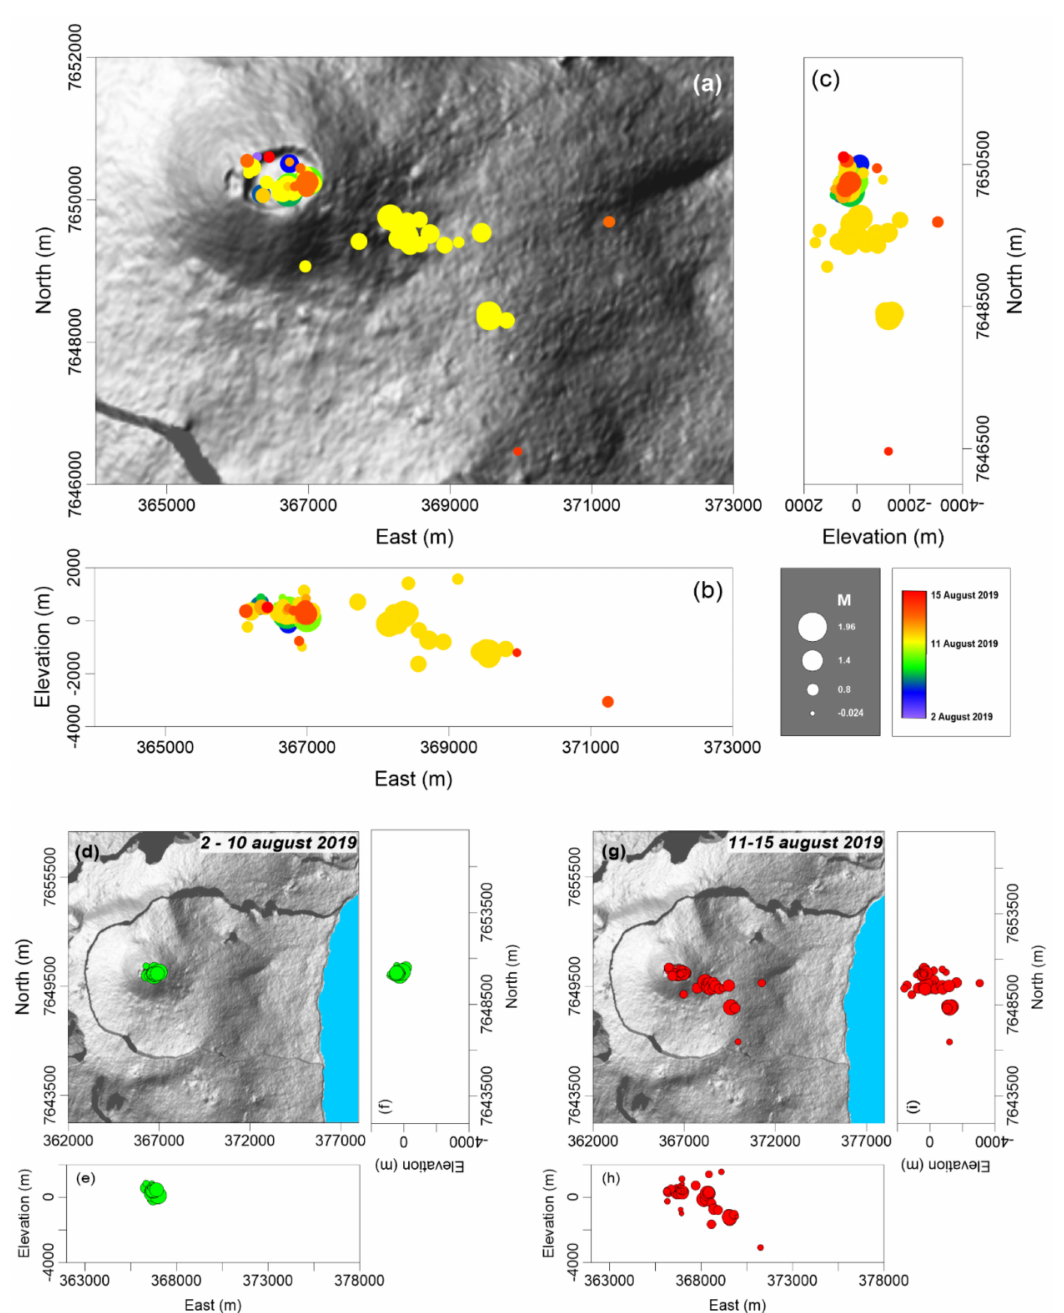
Figure 3. Seismicity analysis: ( a ) seismicity distribution as a function of magnitude (the higher the magnitude, the bigger the circles) and day of occurrence (from blue to red circles), superimposed on the 1 arcsec Shuttle Radar Topography Mission (SRTM) Digital Elevation Model (DEM) of the zone; ( b ) hypocenter distribution by longitude; ( c ) hypocenter distribution by latitude. Maps and sections of the seismicity nucleated during: ( d – f ) the 2–10 August 2019, and ( g – i ) the 11–15 August 2019 time intervals; earthquakes are shown as a function of